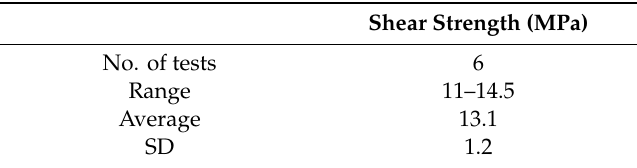
Table 15. Shear strength average value and standard deviation.